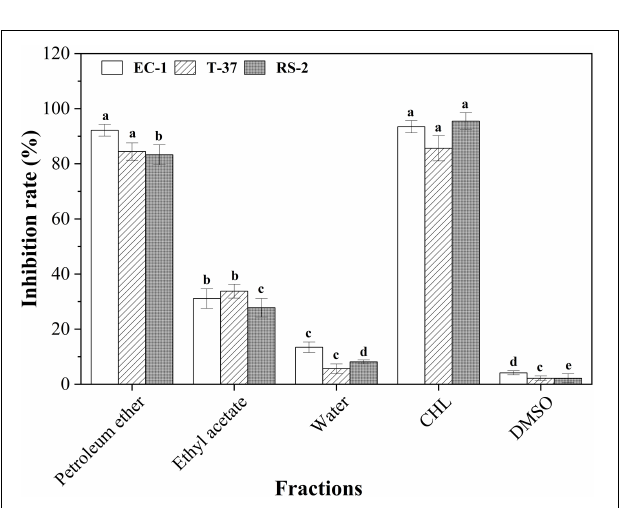
FIGURE 3 | Antibacterial activities of the subfractions A1–A11 of the spore powder against the indicator bacteria. Different lowercase letters indicate significant differences ( p <